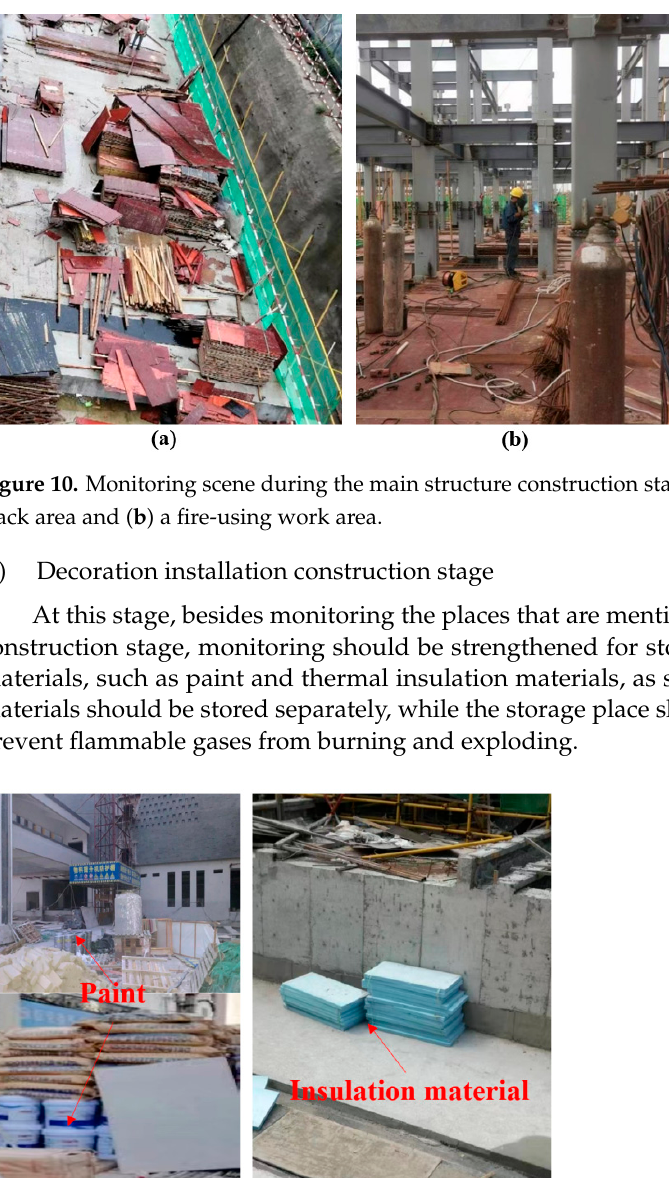
Figure 12. The installation process of insulation boards. 4.2. Visualization Functions As illustrated in Section 2.2, the visualization subsystem can visually present the on- site situation, the entire process of a fire occurrence, and the evacuation route. The evacuation route should be first optimized by the escape route optimization subsystem and then presented to people by the visualization subsystem. Therefore, this section mainly presents the results of visualizing on-site information and fire scenes.